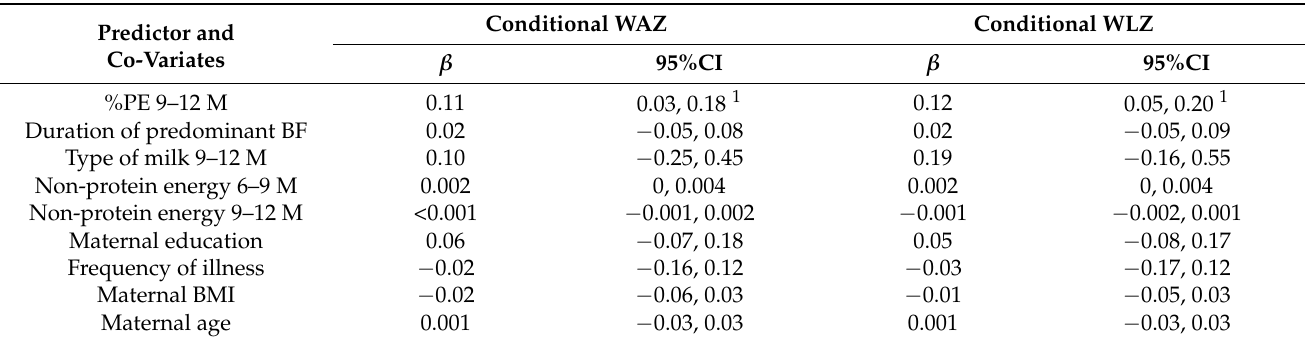
Table 5. 1 Multiple linear regression analyses investigating associations between protein intake from all sources at 9–12 months and conditional